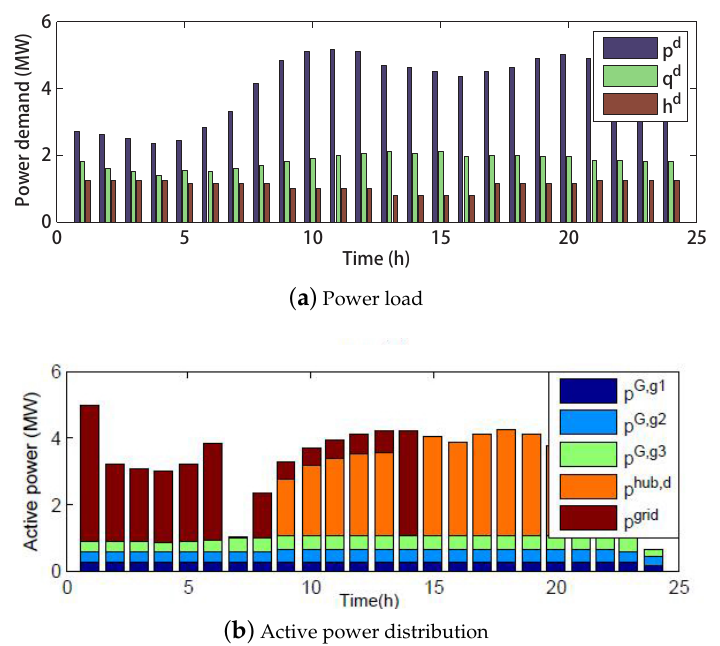
Figure 6. Power load and active power distribution under the Nash balancing